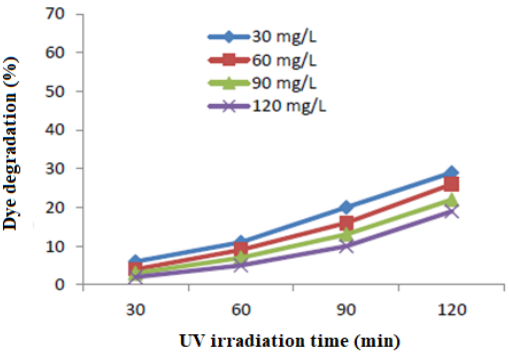
Figure 3. UV irradiation time on % degradation efficiency of Reactive Yellow 160A.